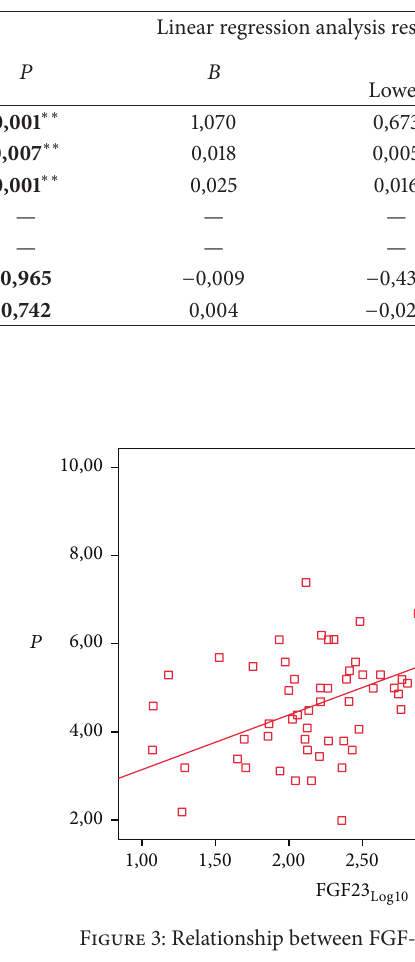
Table 3: Evaluation of factors affecting FGF23